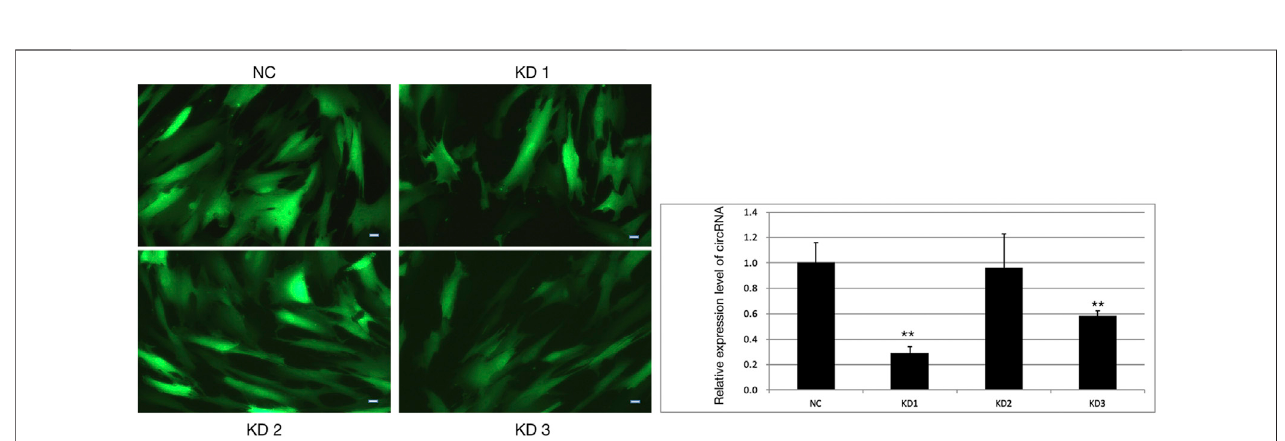
FIGURE9| HBVSMCsinfectedbyfourkindsoflentivirusandtheinfectionef fi ciencyoflentivirusassessedbyqPCR.NC (cid:1) negativecontrol,KD1 (cid:1) lentivirus1used toreducetheexpression ofhsa_circ_0005505,KD2 (cid:1) lentivirus2usedtoreducetheexpressionofhsa_circ_0005505,KD3 (cid:1) lentivirus3usedtoreducetheexpression of hsa_circ_0005505. Scale bar (cid:1) 50 μ m.